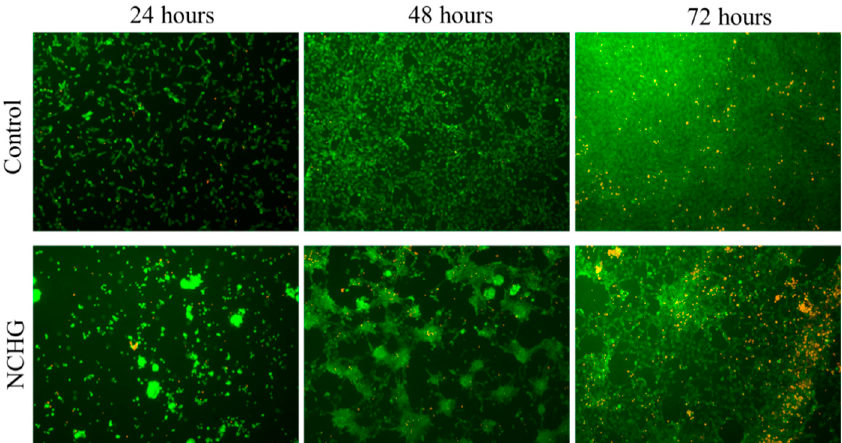
Figure 11. Vitality staining of MG63 cells. The cells were seeded onto hydrogel samples (NCHG) and untreated coverslips (Control) and cultured for 24, 48, and 72 h. After the incubation period, cells on the different surfaces were co-stained by fluorescein diacetate and propidium iodide.